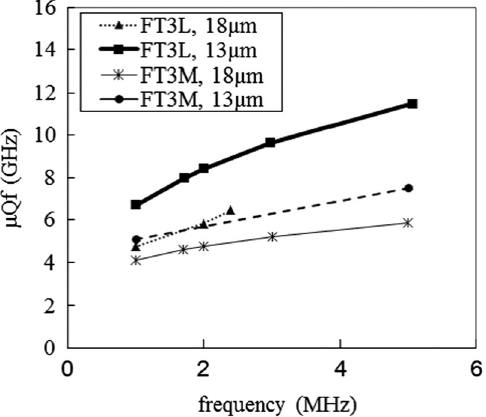
FIG. 1. Magnetic flux density dependence of magnetic mate- rials. The vertical axis is the product of (cid:1) 0 p Qf (relative parallel permeability, Q value, and frequency), which is proportional to the shunt impedance. Ferrite A is a typical low- Q ferrite core with 500 mm O.D. where the magnetic flux density dependence was observed. Ferrite B is a high- Q type; however, it also shows the so-called high loss effects. FT3M-small and FT3M-large denotes MA cores of 570 mm O. D. and 70 mm O.D., respec- tively. These MA cores show a constant shunt impedance up to 2